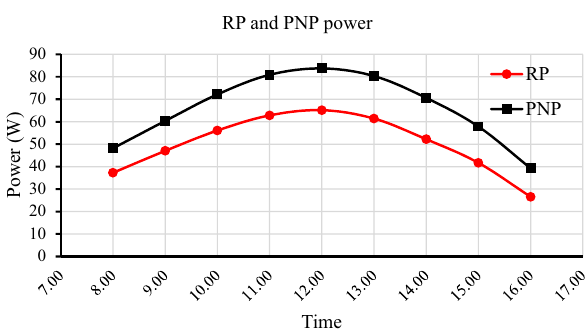
Figure 17. The RP and PNP power after self-cleaning with